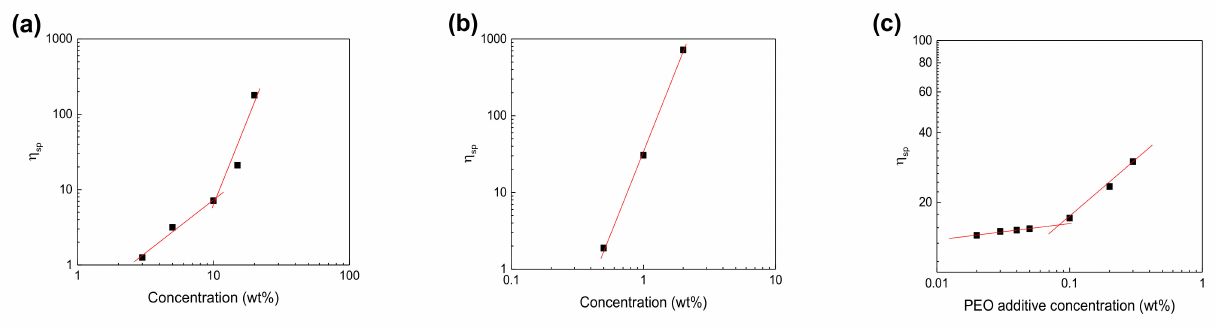
Figure 2. Dependence of specific viscosity on concentration of ( a ) Nafion/MeOH dispersions, ( b ) PEO/MeOH dispersions, and ( c ) 10 wt % Nafion-PEO/MeOH